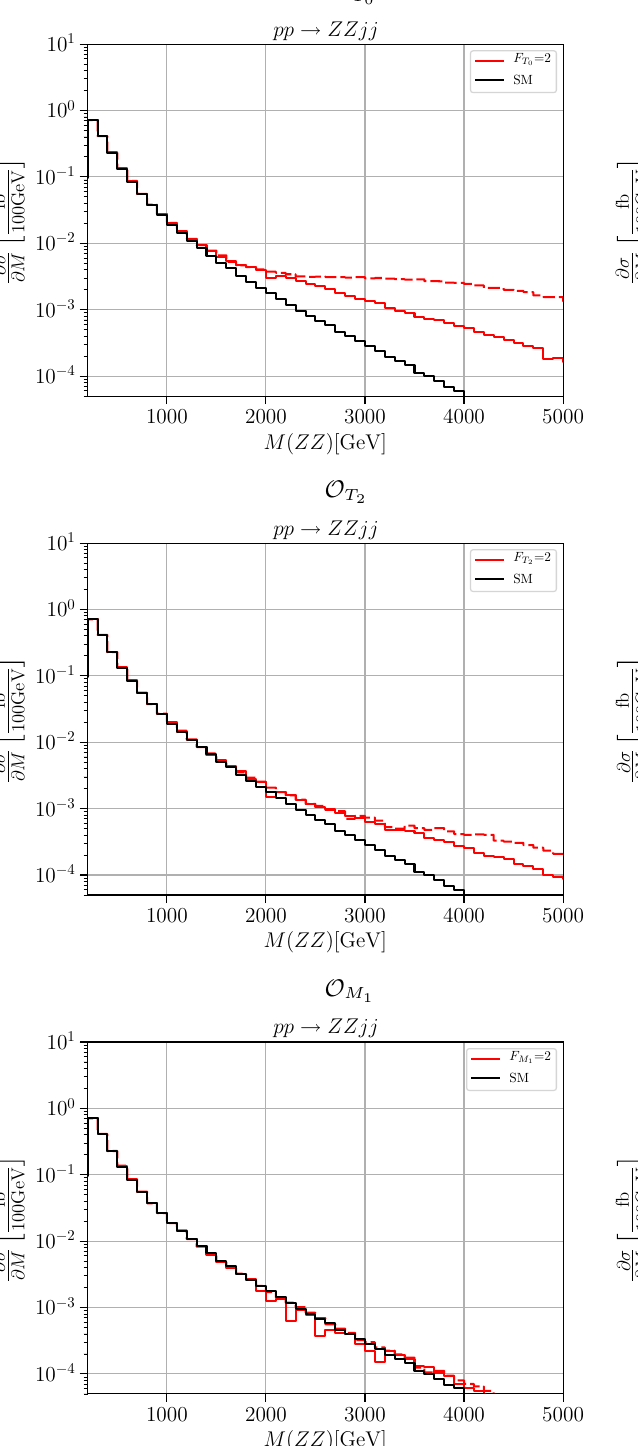
O O T 0 , 1 , 2 and M 0 , 1 , 7 (dashed: naive EFT, solid: unitarized model).